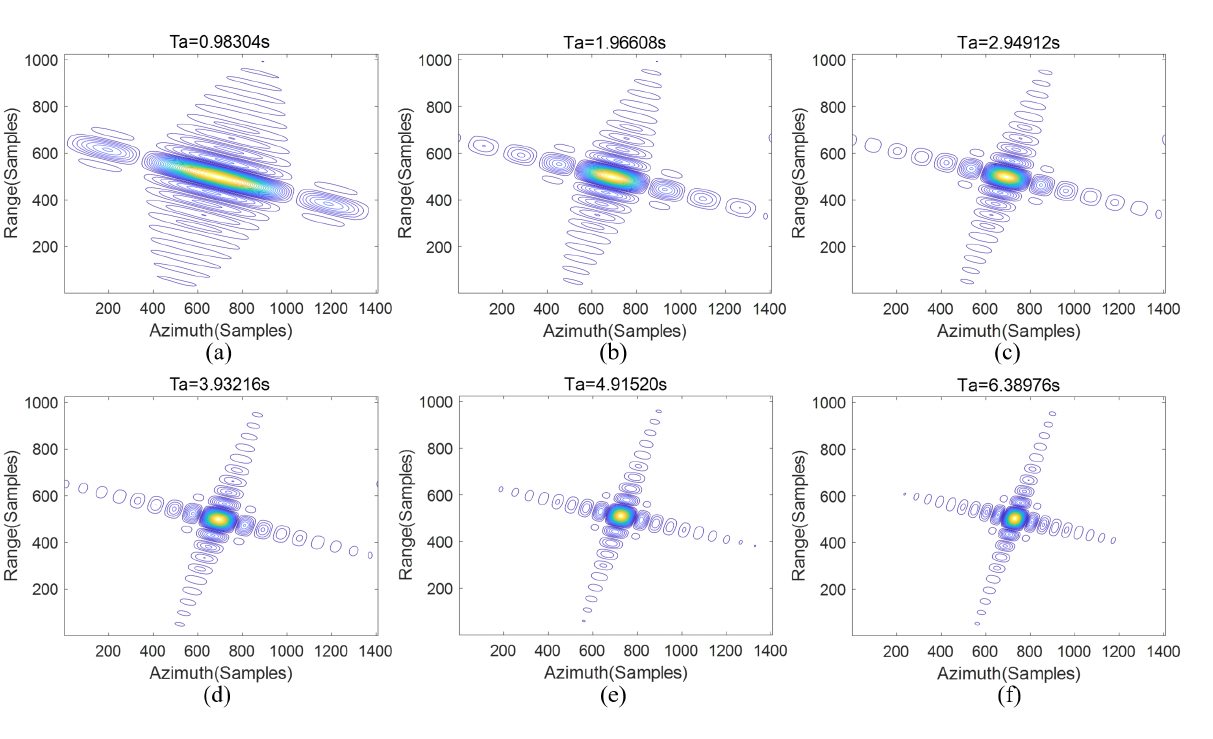
Figure 4. Coherent synthesis results of the proposed real-time processing with a synthetic aperture time of about ( a ) 0.98 s, ( b ) 1.97 s, ( c ) 2.95 s, ( d ) 3.93 s, ( e ) 4.92 s, and ( f ) 6.39